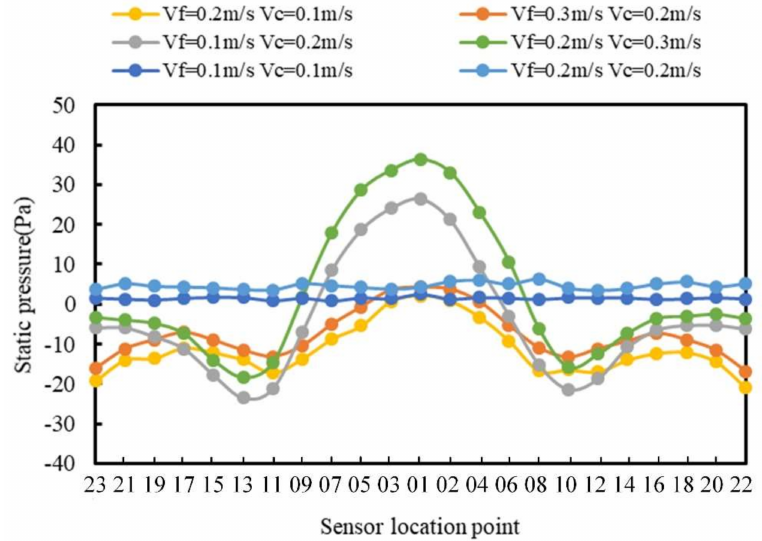
Figure 17. Pressure distribution when V f and V c are in the same